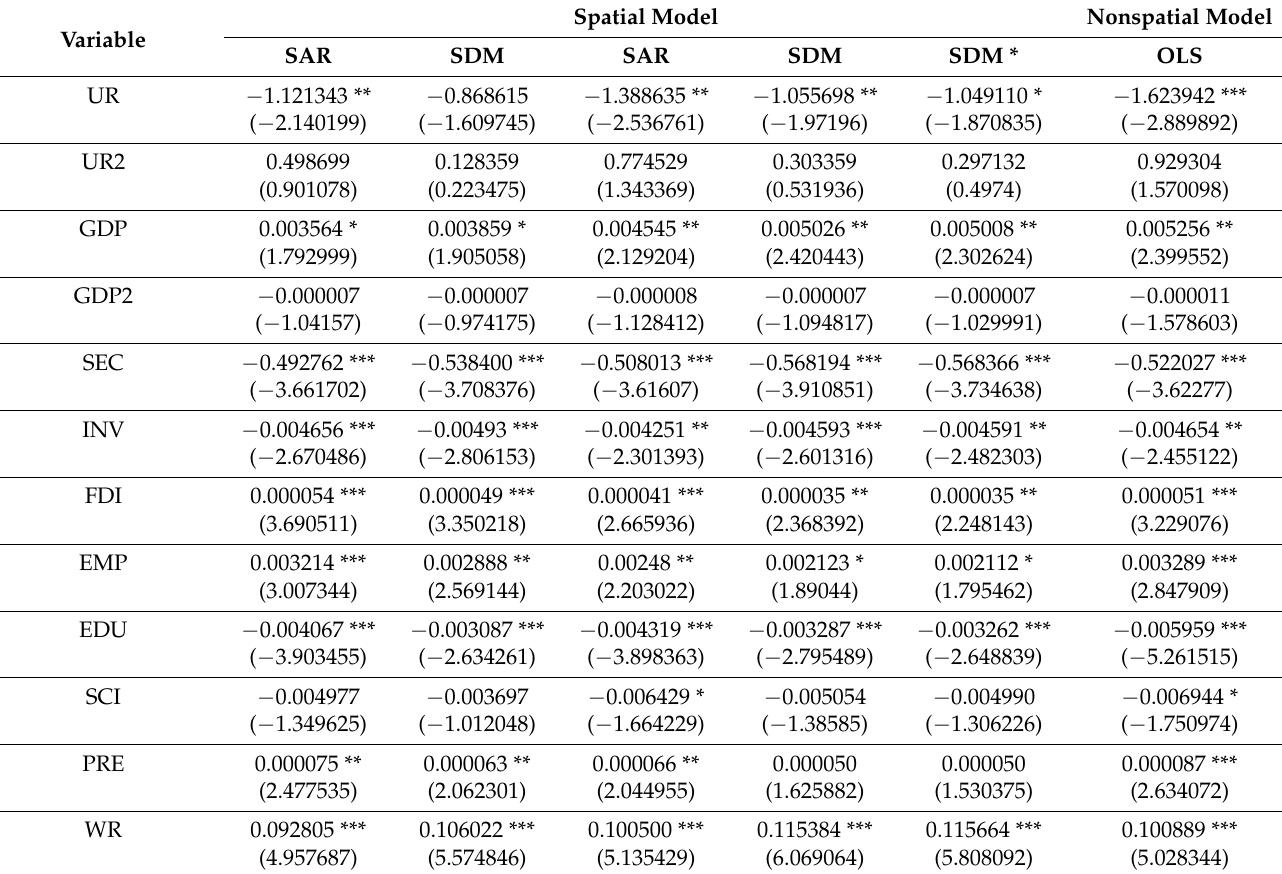
Table 3. Estimation results of SAR and